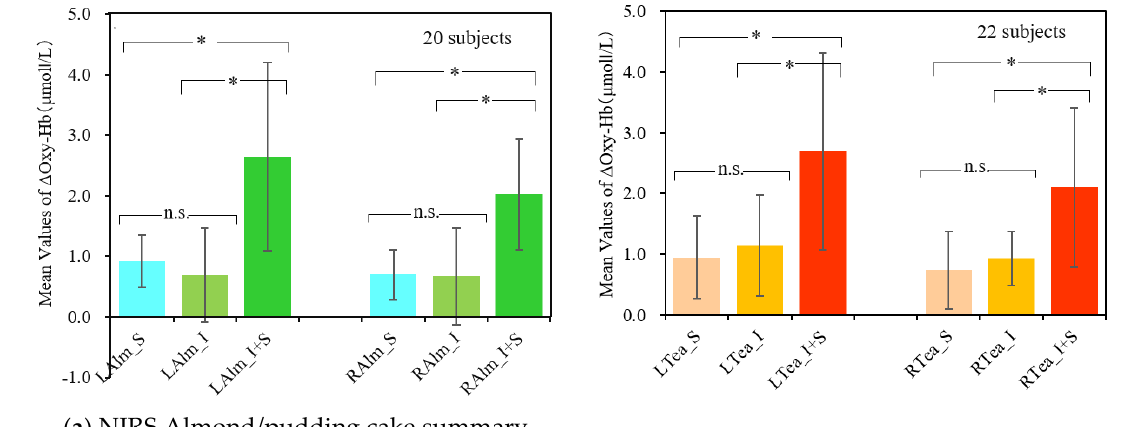
Figure 11. NIRS results of the bergamot tea study, clarified by integrating 12 subjects. (Solid Lines/Dotted Lines: Left/Right temple regions). (Red/Black: Oxy-Hb/Deoxy-Hb).